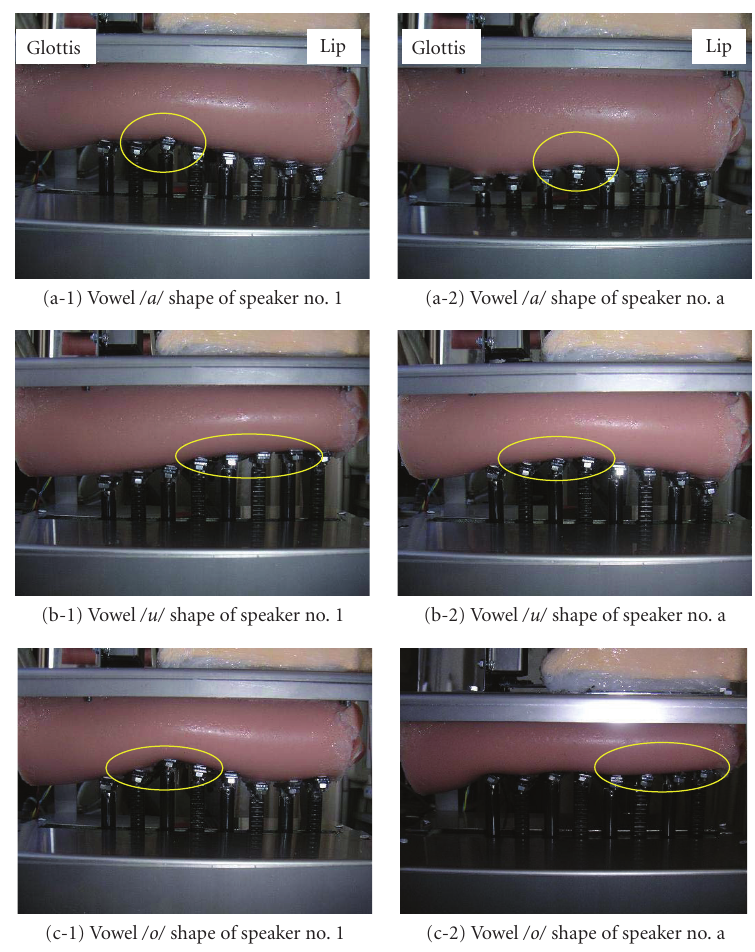
Figure 5: Comparison of vocal tract shapes of the hearing-impaired (right) with the able-bodied (left).